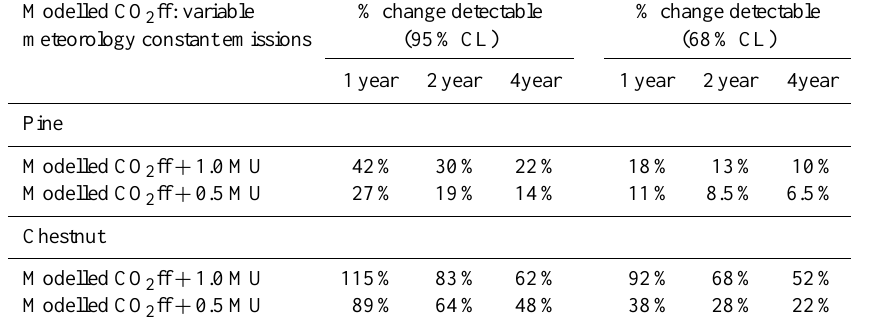
Table 3. Detection limits for samples at the pine and chestnut trees, calculated with modelled CO 2 ff at constant emissions and six years of observations in reference period (2004–2011). Limits are given at the 2-sigma (95%) and 1-sigma (68%) confidence level (CL) for samples representing an average of one, two, or four years. Measurement uncertainty (MU) of 1.0 or 0.5ppm is added in quadrature to the standard deviation of modelled CO 2 ff before limits are calculated. Modelled CO 2 ff: variable % change detectable % change